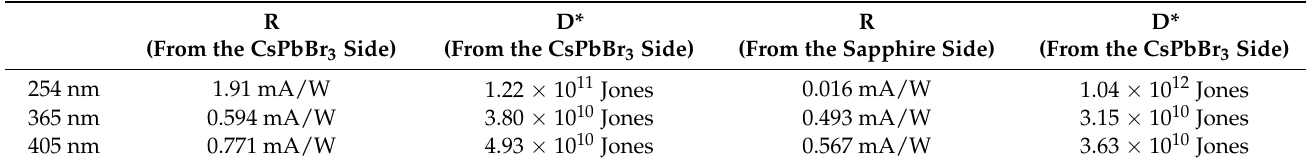
Table 2. The R and D* of the Ga 2 O 3 /CsPbBr 3 heterojunction PD.